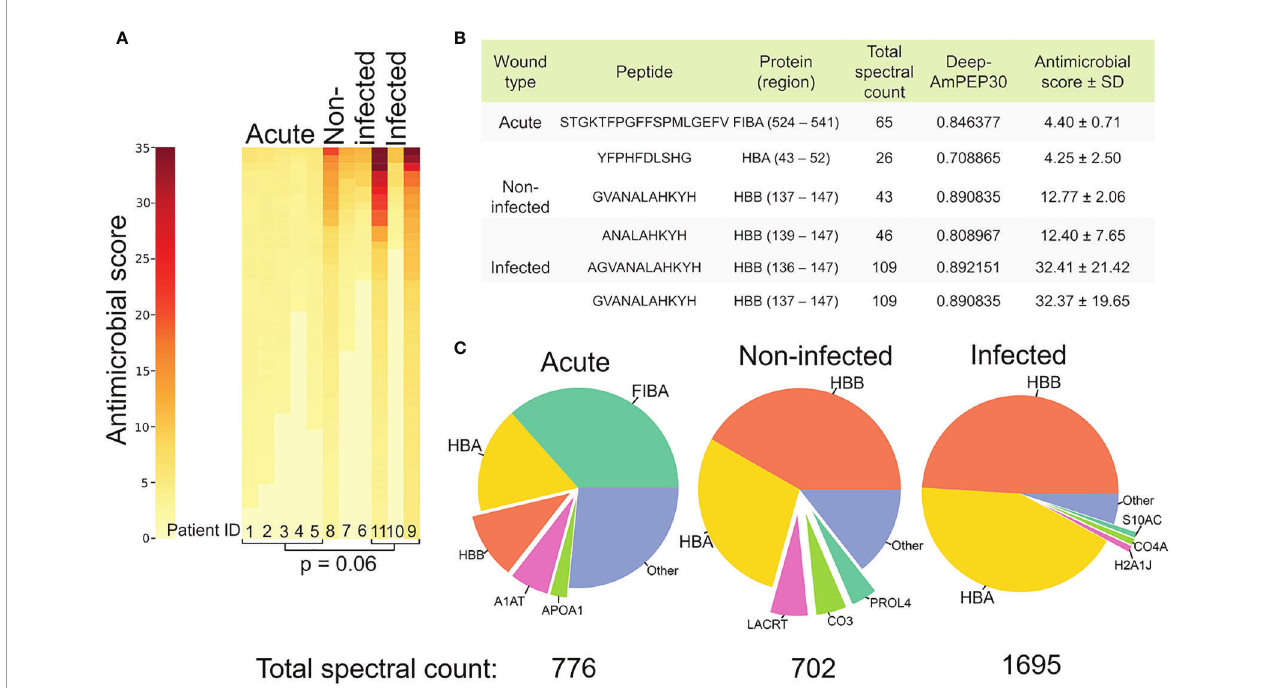
FIGURE 6 | Increased antimicrobial activity in infected samples. (A) Heatmap depicting the predicted antimicrobial environment in the different samples. Heat map color is determined by the antimicrobial score, which was calculated by multiplying the retrieved prediction score from Deep-AmPEP30 with the respective spectral count for each sequence. A cut-off value (0.7) was applied on the Deep-AmPEP30 prediction score. (B) Table highlighting the peptides with the highest antimicrobial score in each group. (C) Pie charts showing the proportions of parent proteins generating the antimicrobial